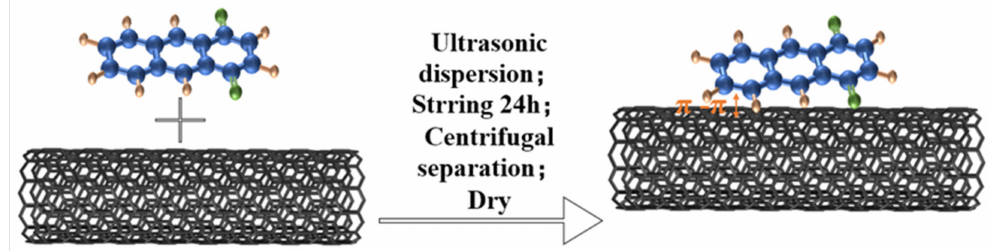
Figure 1. Schematic diagram of the synthesis of PAQ/MWCNTs composites.